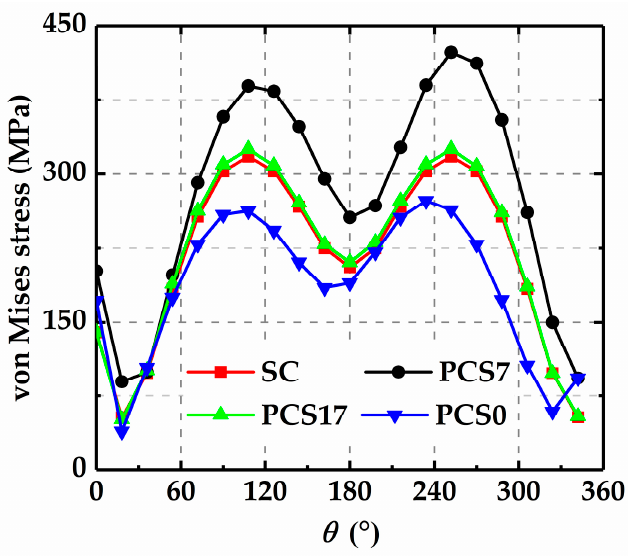
Figure 15. Von Mises stress distributions in the vicinity of tip A.